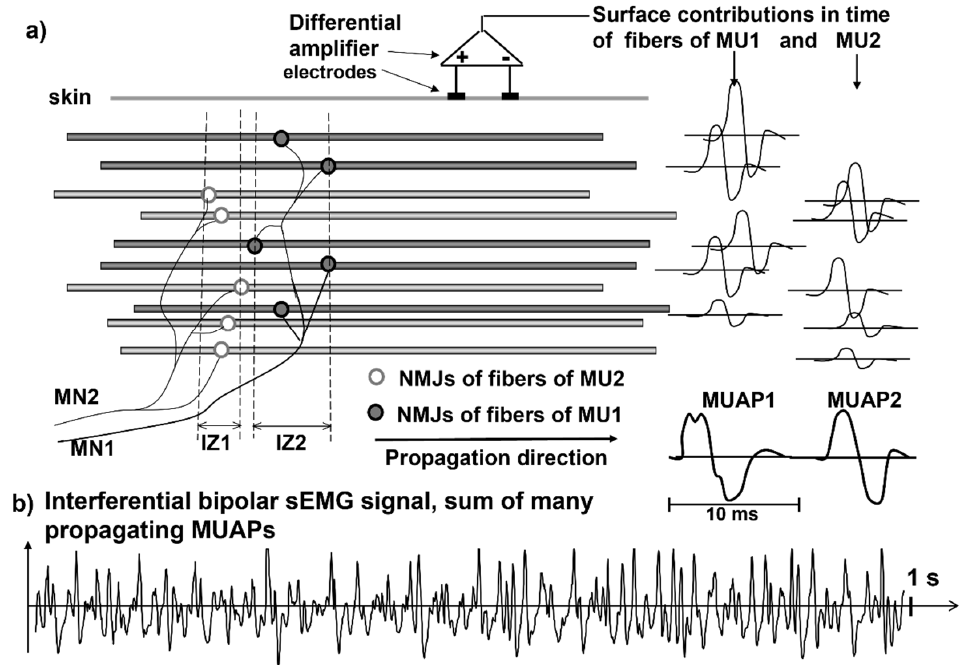
Figure 3. Schematic representation of the fibers of two motor units (MU1 and MU2) that are innervated by two motoneurons (MN1 and MN2) in two innervation zones (IZ1 and IZ2): ( a ) the summation of the skin contributions of the propagating action potentials, as detected by a differential amplifier (bipolar or single differential detection), are depicted as MUAP1 and MUAP2 (observe that the contributions of deeper muscle fibers are smaller than those of the superficial fibers of each MU); ( b ) the interferential signal, which is the summation of the MUAP trains of many active MUs. Modified from Figure 5.1 of [22] with permission.